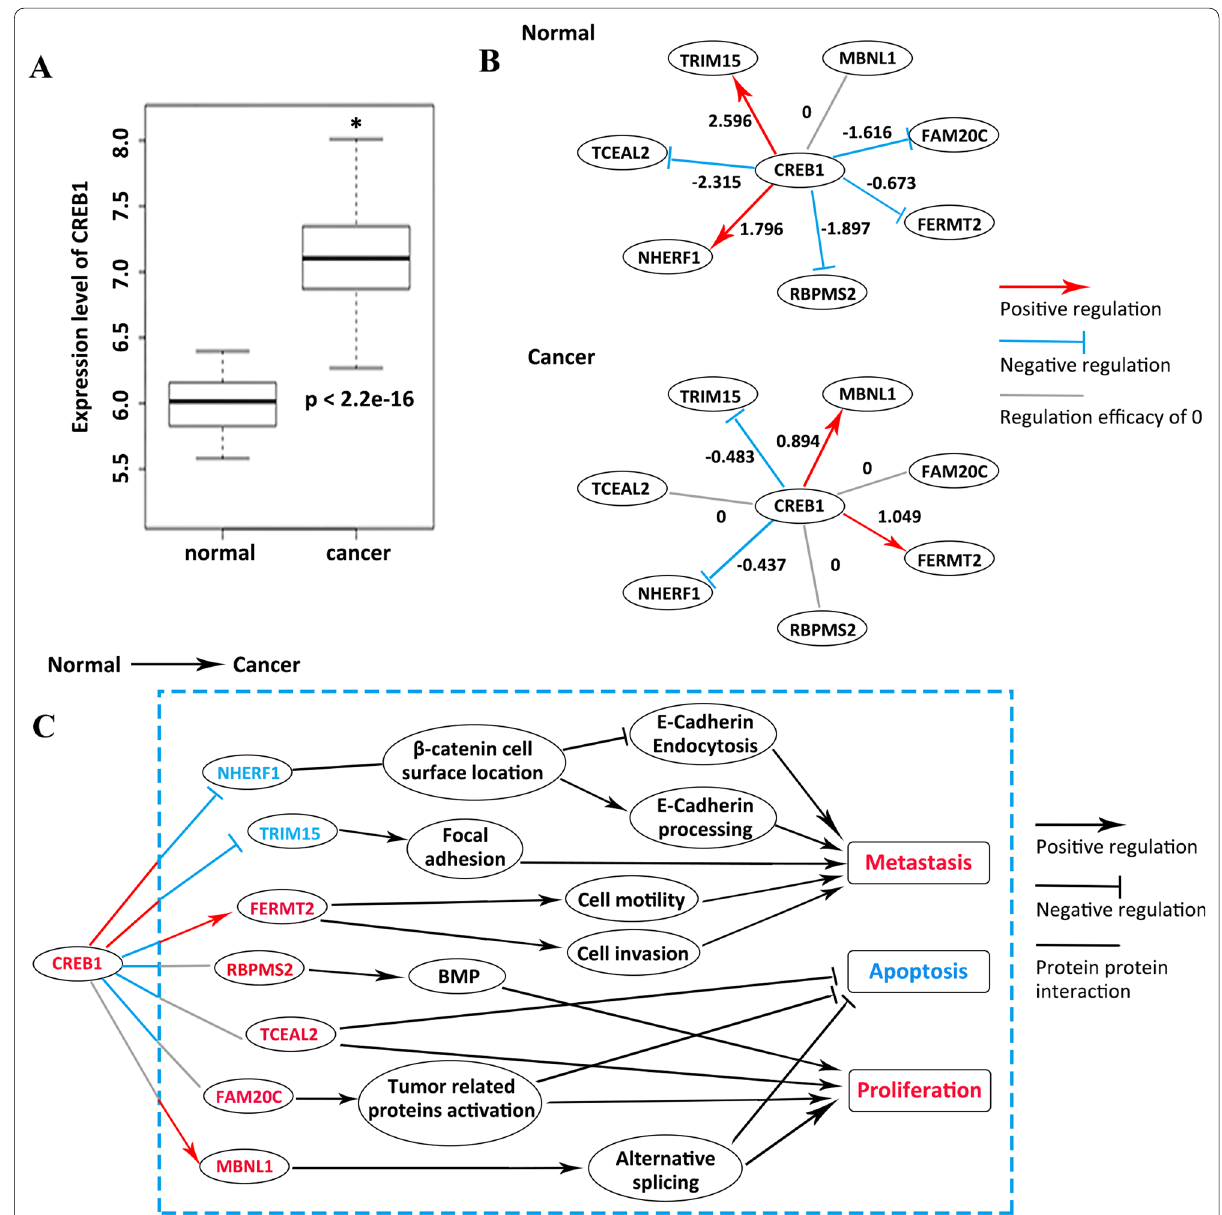
Fig. 2 The proposed dysregulation mechanisms around CREB1. A The expression level of CREB1 in GSE54129 dataset. B CREB1 is a TF, and the other nodes are its targets. Links in red, blue and grey represent positive, negative and absent relationships calculated with dataset GSE54129. Numbers on the links indicate the regulation efficacies. C The proposed mechanism by which CREB1 induces GC. *Means significant P ‑value < 0.05,